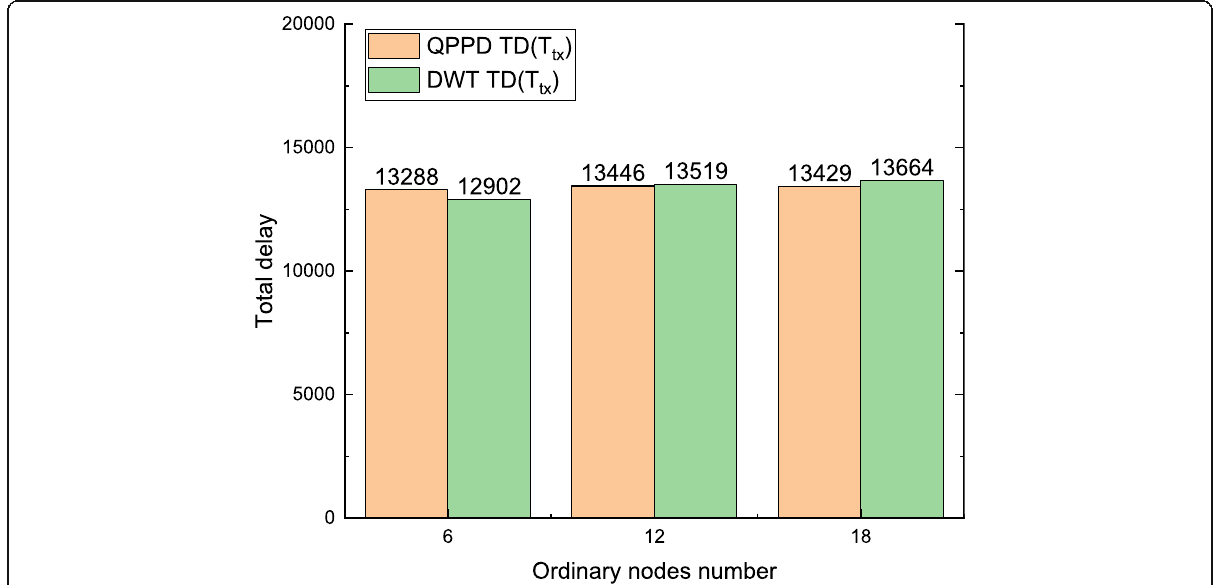
Fig. 24 The total number of periodic data changes increases from 0 to 3; the total